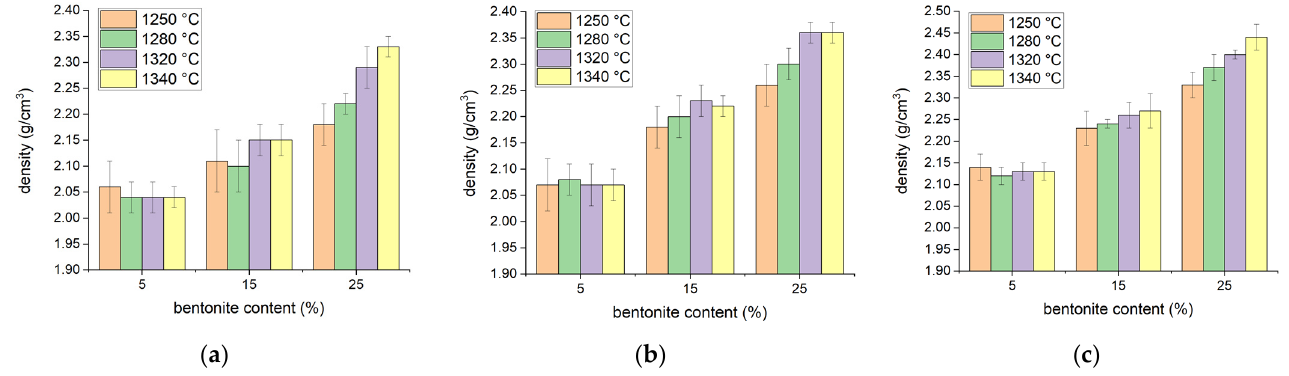
Figure 2. Content of bentonite binder vs. density of ceramics based on electrocorundum F240 pressed at ( a ) 20; ( b ) 30; and ( c ) 40 MPa. Sintering temperature is indicated in a legend.